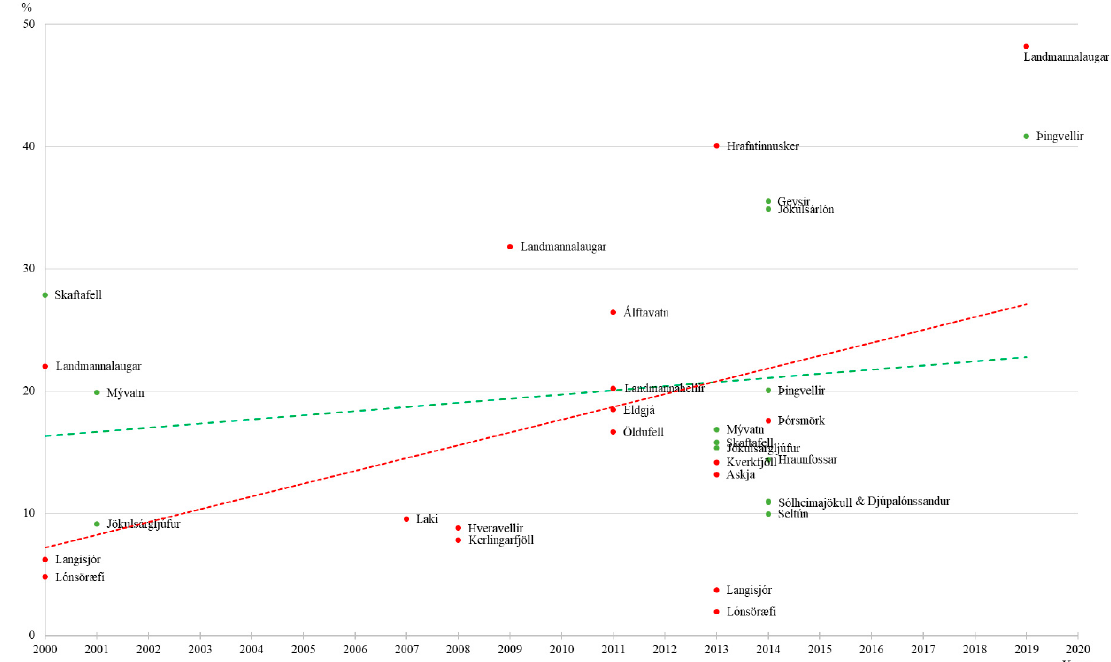
Figure 4. Proportion of summer visitors who consider the number of visitors as many or too many. Red dots destinations in the Highlands. Green dots destinations in the Lowland. Derived from data in: [12,80,84–86] .